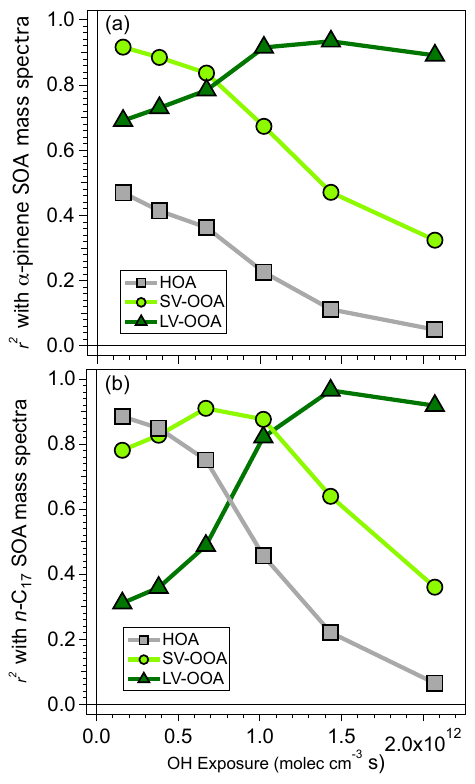
Fig. 5. Linear correlation coefficient ( r 2 ) between mass spectra of PAM-generated (a) α -pinene SOA and (b) n -C 17 SOA and ambi- ent hydrocarbon-like organic aerosol (HOA), ambient semivolatile OOA (SV-OOA), and ambient low-volatily OOA (LV-OOA) factors (Ng et al., 2011a) as a function of OH exposure in the PAM